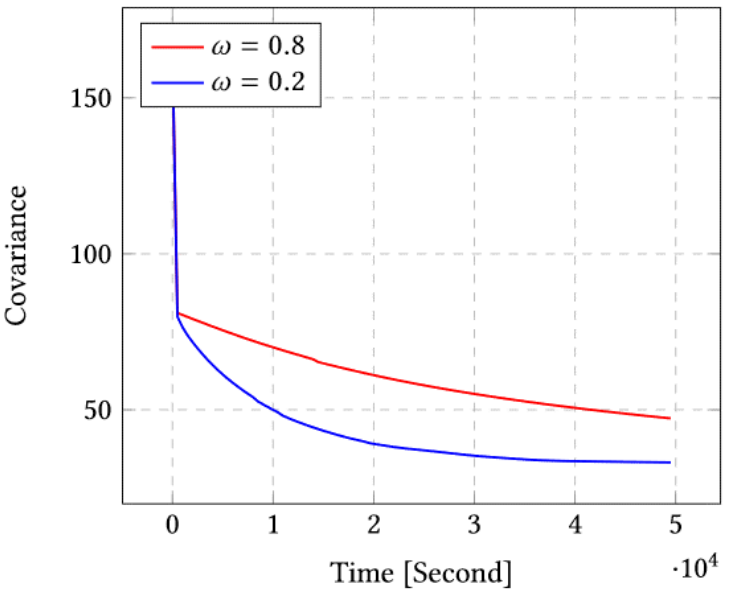
Figure 6. Covariance for ω = 0.8 and ω = 0.2 for the case of 20